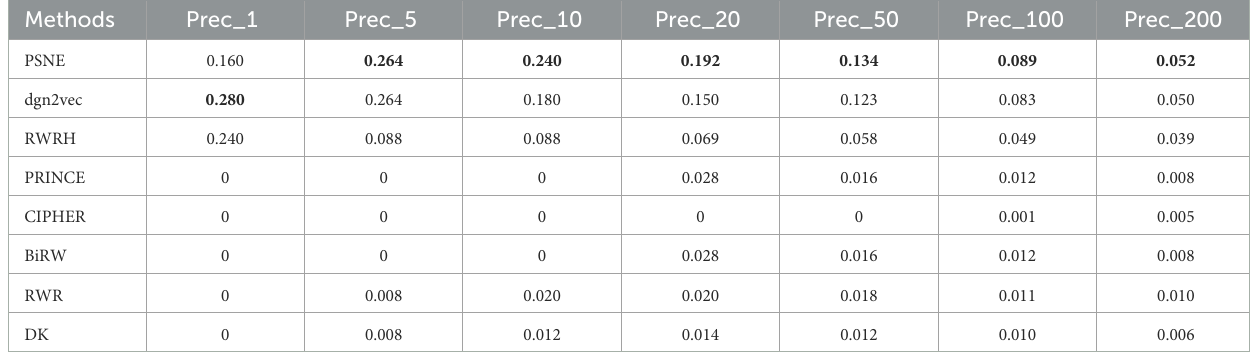
TABLE 6 For Parkinson’s disease, the performance evaluation of PSNE in terms of top-k Precision (k = 1, 5, 10, 50, 100, and 200), with comparison to the state-of-the-art